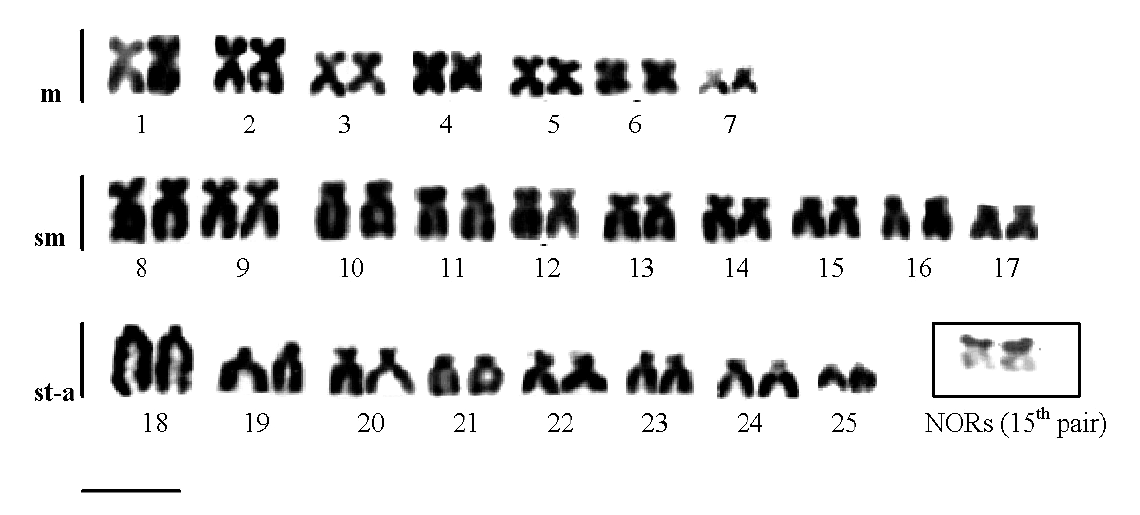
F IGURE 1.- Giemsa-stained karyotypes of Alburnoides bipunctatus from the Caspian Sea basin. The NOR- bearing chromosome pair, after silver staining, is shown in the box. Bar = 5 µm